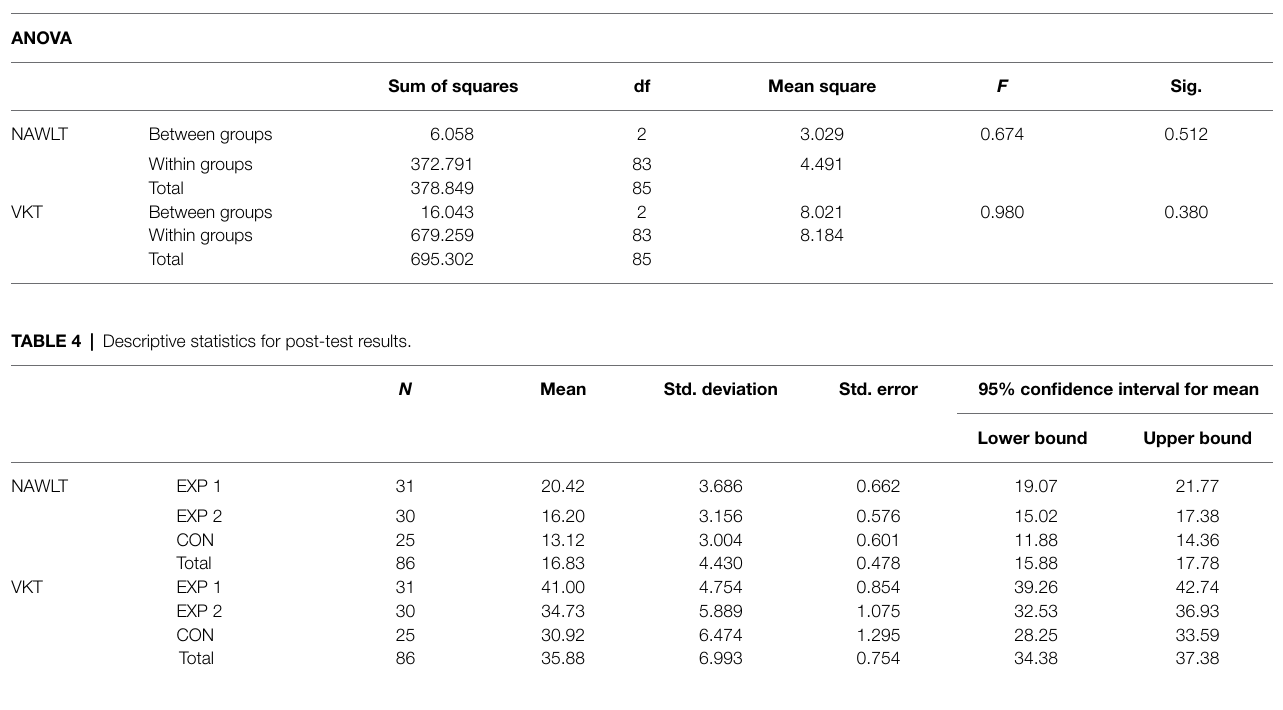
Levene’s df1 df2 statistic